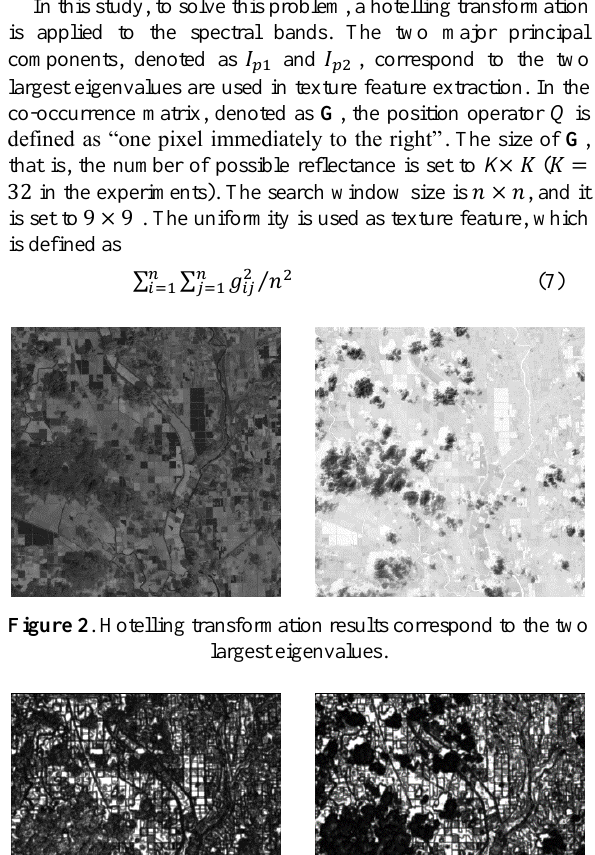
Figure 5 . Dataset II : Tibet, China.